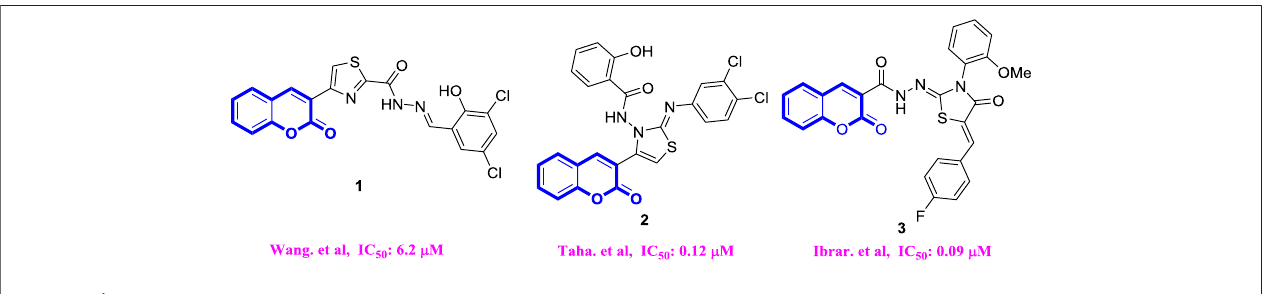
FIGURE 1 | α -glucosidase inhibitors containing